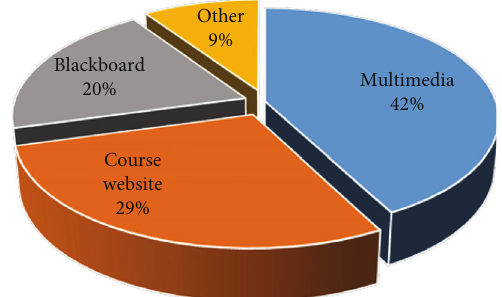
Figure 4: The main teaching methods adopted in thought-political courses.